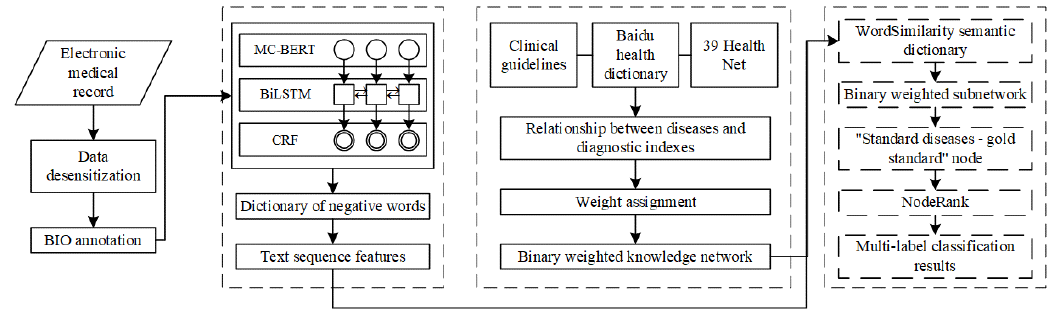
Figure 1. Framework of the DLKN-MLC model.